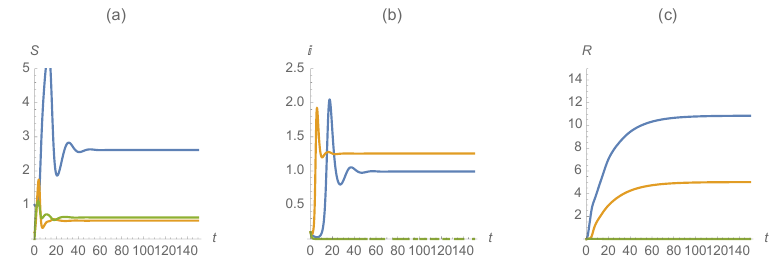
Figure 9. ( a ) S j , ( b ) I j , and ( c ) R j . The first disease is represented in blue, the second in orange and those susceptible/infected/recovered by diseases in green.